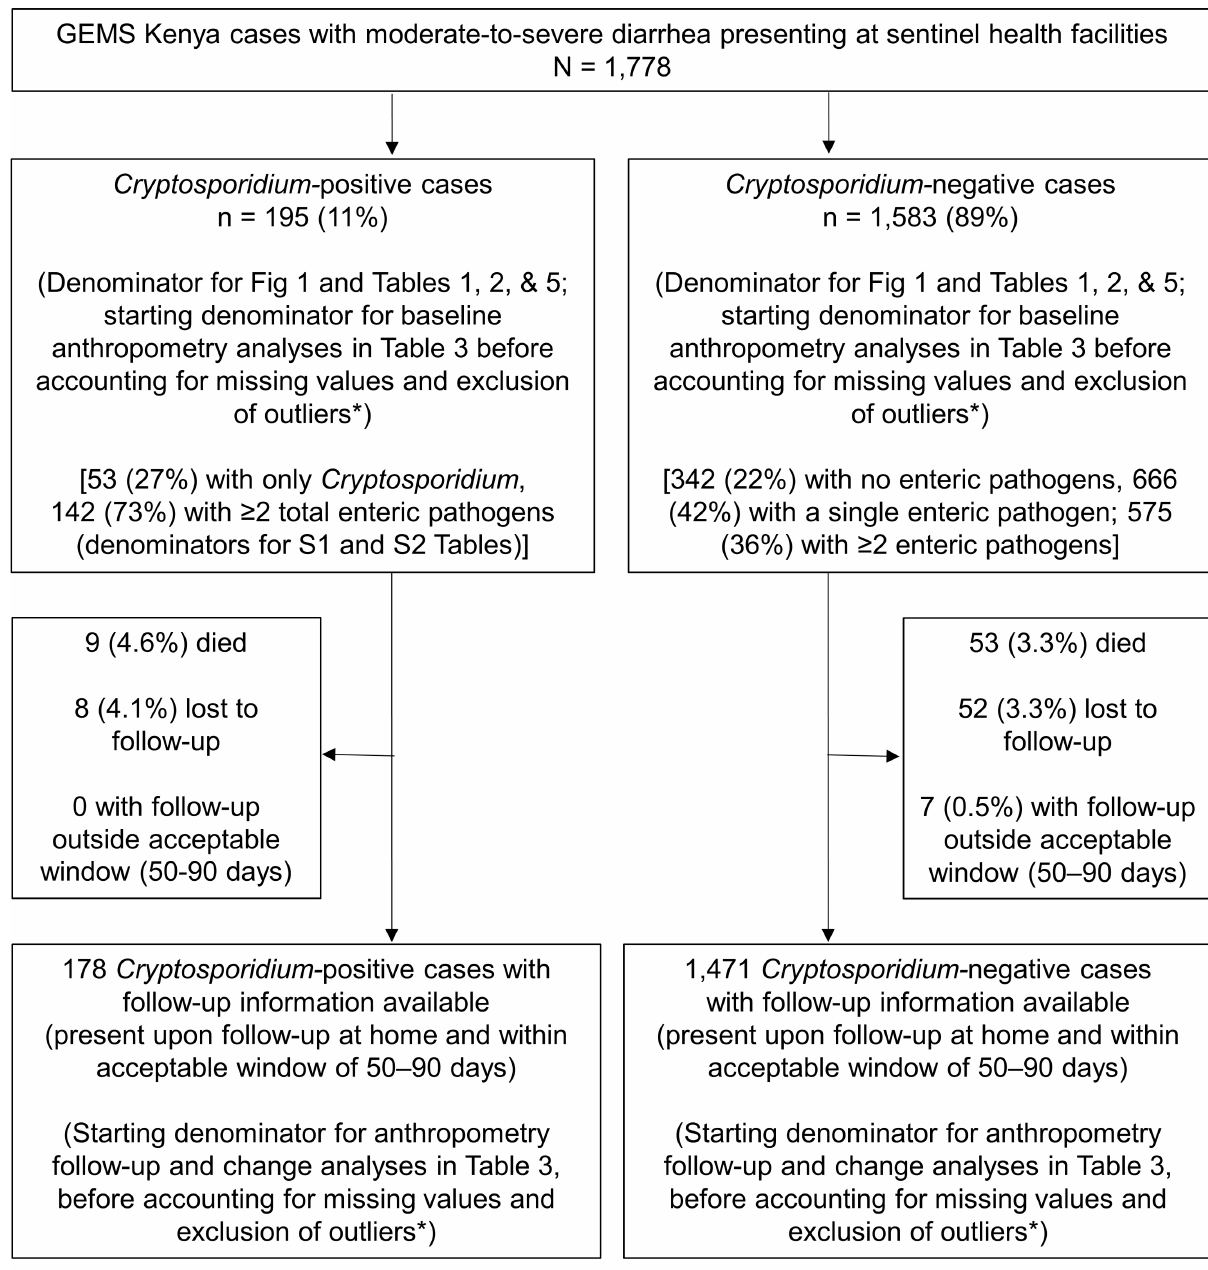
PLOS NeglectedTropical Diseases | https://doi.org/10.1371/journal.pntd.0006640 July 12,